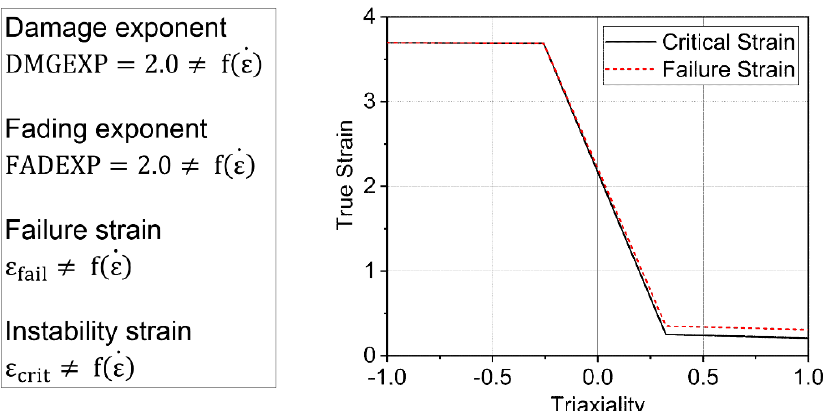
Figure 4. Damage parameters (failure strain).